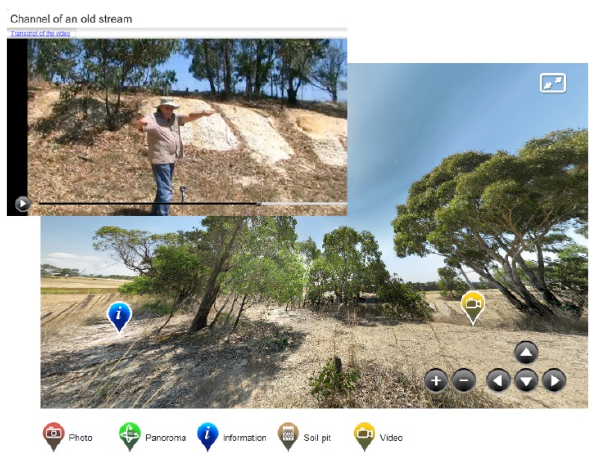
Figure 3: Victorian Resources Online http://vro.depi.vic.gov.au/dpi/vro/wgregn.nsf/pages/wg_soil_ma ffra_briagolong